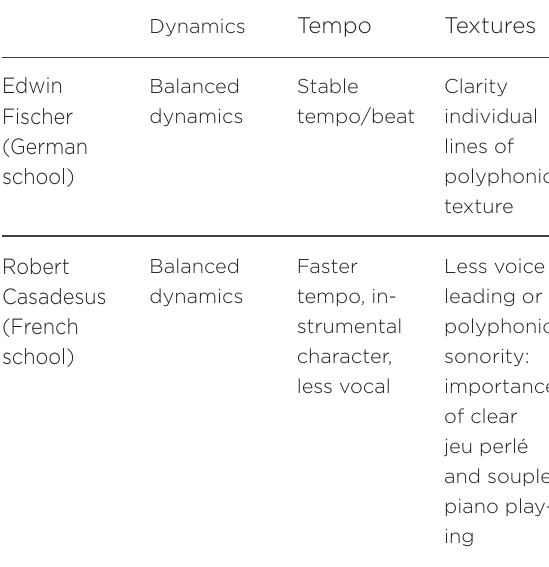
Table 1 . Beethoven, Sonata op. 57. Appassionata, first movement